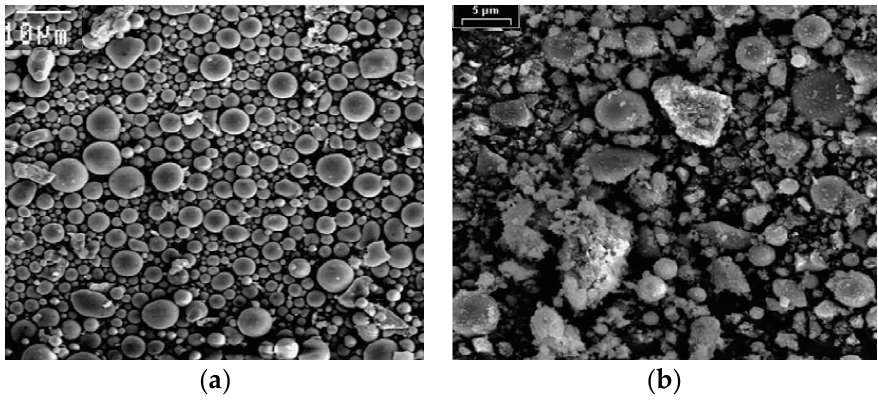
Figure 2. Particle size distribution curves of the fly ash.